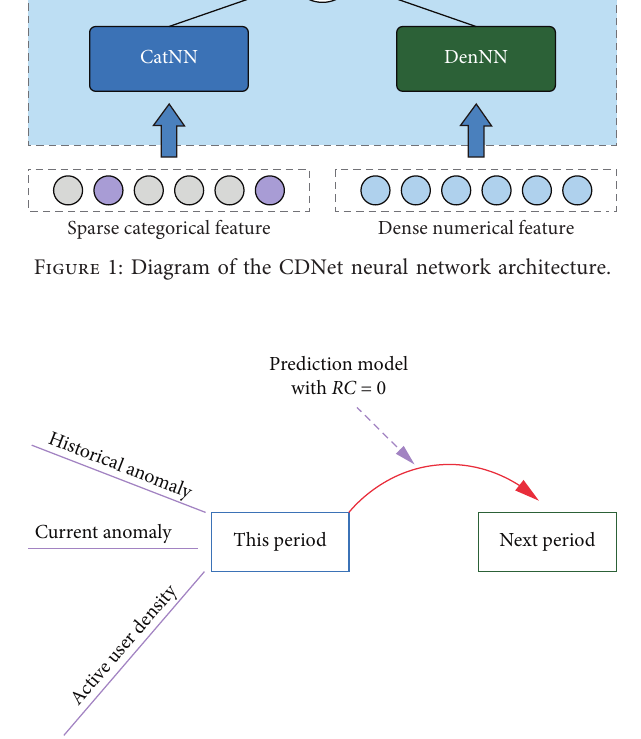
Figure 2: Illustration for the prediction stage of the